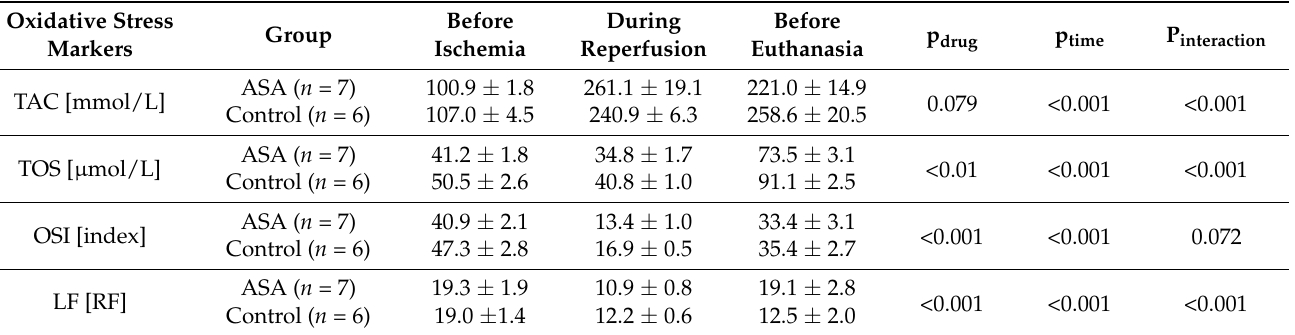
Table 4. Oxidative stress marker levels in the serum of pigs subjected to a myocardial ischemia- reperfusion protocol assessing the effectiveness of intracoronary administered acetylsalicylic acid (ASA). The results are presented as mean ± standard deviation and were analyzed using two-way ANOVA.